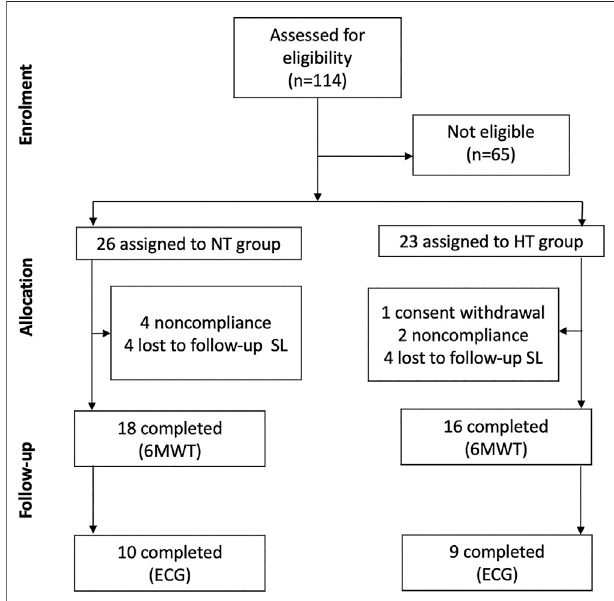
FIGURE 1 | Study design. Flow chart diagram representing the enrollment and the experimental procedure. NT: non-hypertensive; HT: hypertensive; SL: sea level; 6MWT: six minutes walking test; ECG: